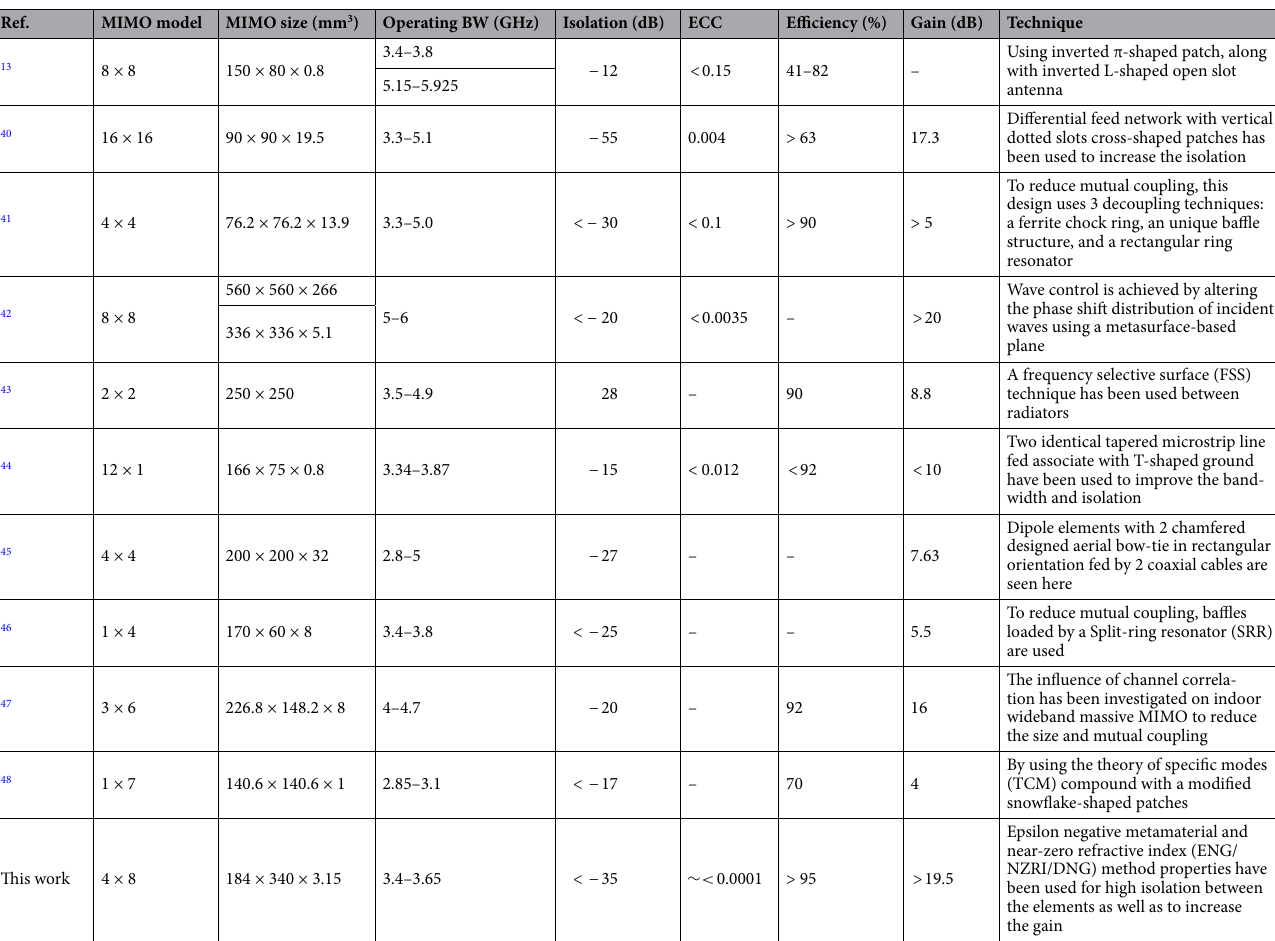
Table 1. Comparisons of the proposed performance to the published state-of-the-art